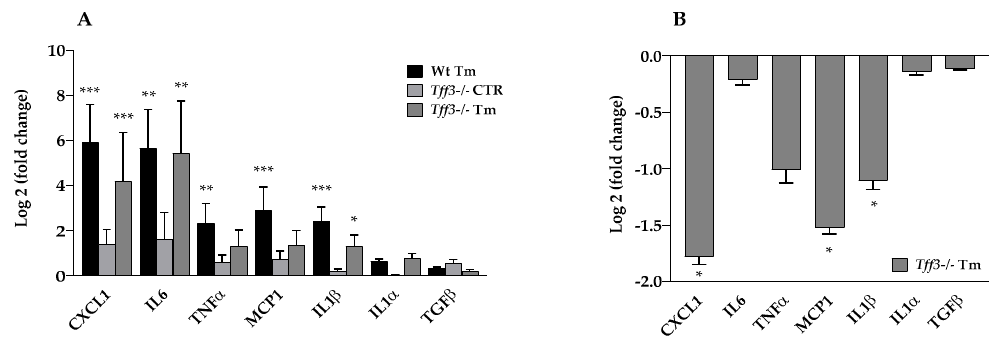
Figure 4. Effect of tunicamycin treatment on the expression of cytokine genes in Wt and Tff3 -deficient mice. We performed qPCR using SYBR green detection for each group ( n = 5 animals per group), C t data were analyzed by REST program and presented relative to Wt control as log2 (fold change) ( A ). Expression of genes in tunicamycin-treated Tff3 − / − mice was expressed relative to the Wt tunicamycin-treated mice ( B ). * p ≤ 0.05, ** p ≤ 0.01, *** p ≤ 0.001; Wt Tm = wild type tunicamycin-treated mice, Tff3 − / − CTR = Tff3 deficient untreated mice, Tff3 − / − Tm = Tff3 − / − tunicamycin treated mice.